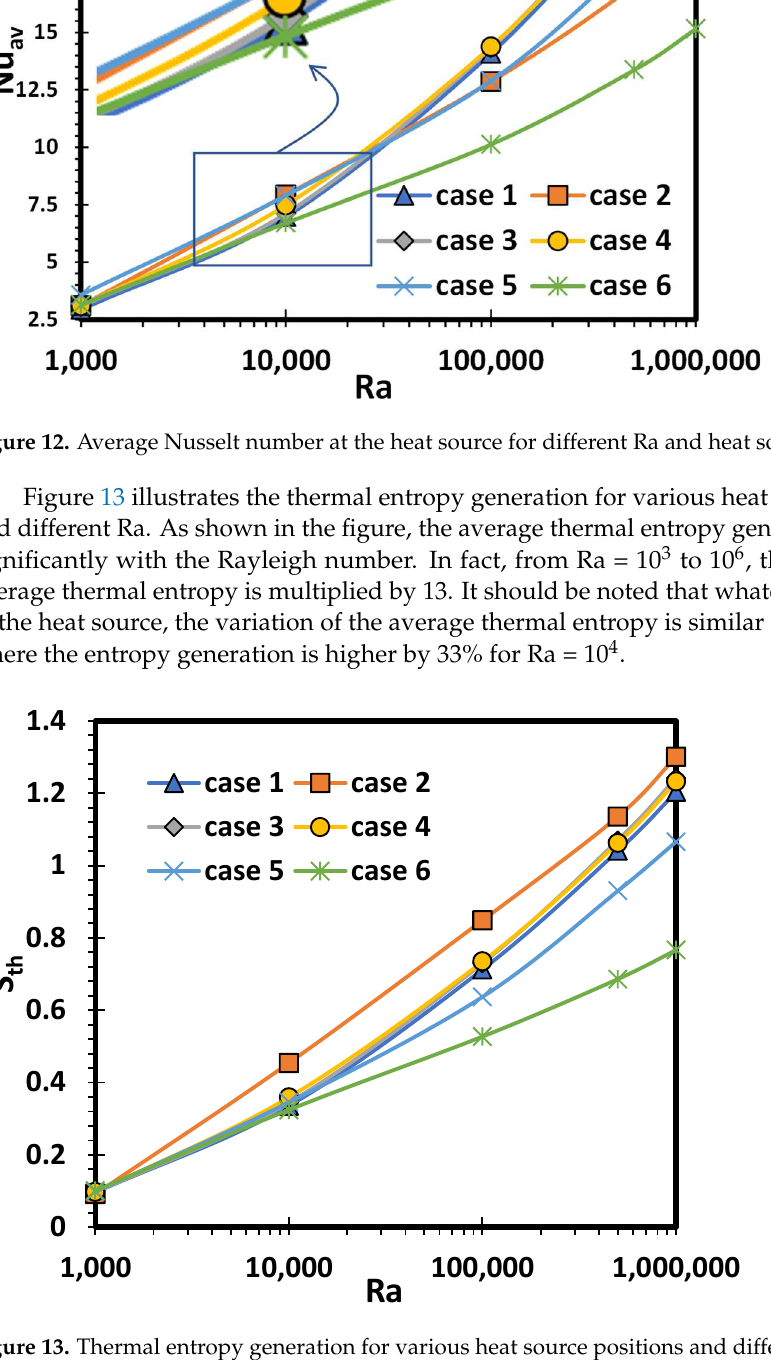
Figure 14. Viscous entropy generation for various heat source positions and different Ra. It is also necessary to mention that the value of the thermal entropy is insignificant compared to the viscous one, which confirms the similar variation between the viscous and total entropy indicated in Figure 15.